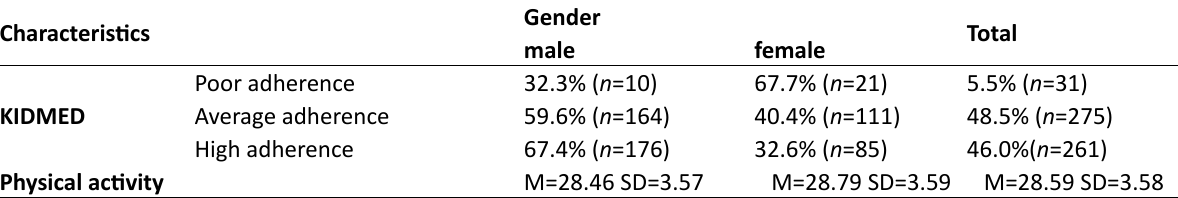
Table 1. Characteristics of the MD and PA based on gender Characteristics